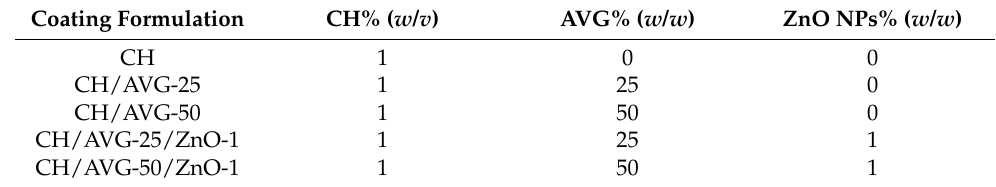
Table 1. Compositionofchitosan-basedcoatingformulationscontainingaloeveragelandZnOnanoparticles. Coating